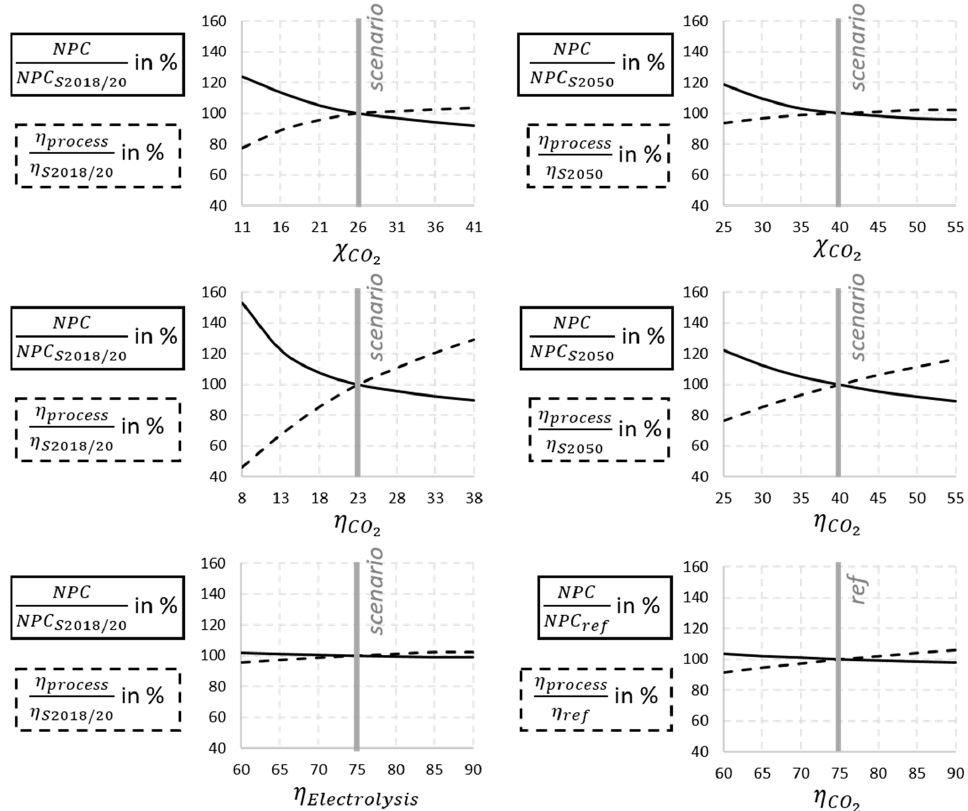
Figure 11. Sensitivity analysis of the plasma reactor and electrolysis parameter. The dotted line describes the process e ffi ciency, the solid line the net production costs ( 𝑁𝑃𝐶 ).